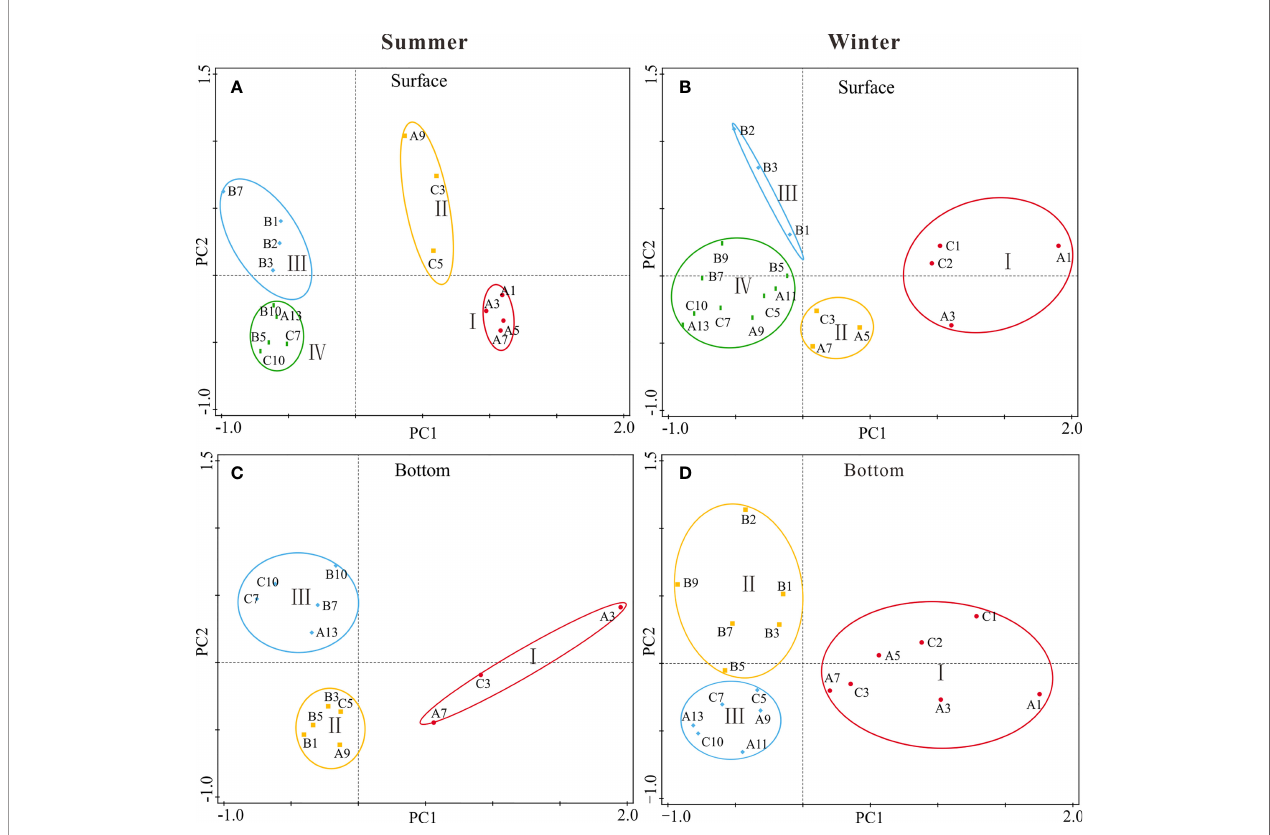
FIGURE 5 | PCA results of environmental and biological characteristics in surface (A, B) and bottom (C, D) seawater along transections (A – C) of the GGBA in summer (A, C) and winter (B, D)